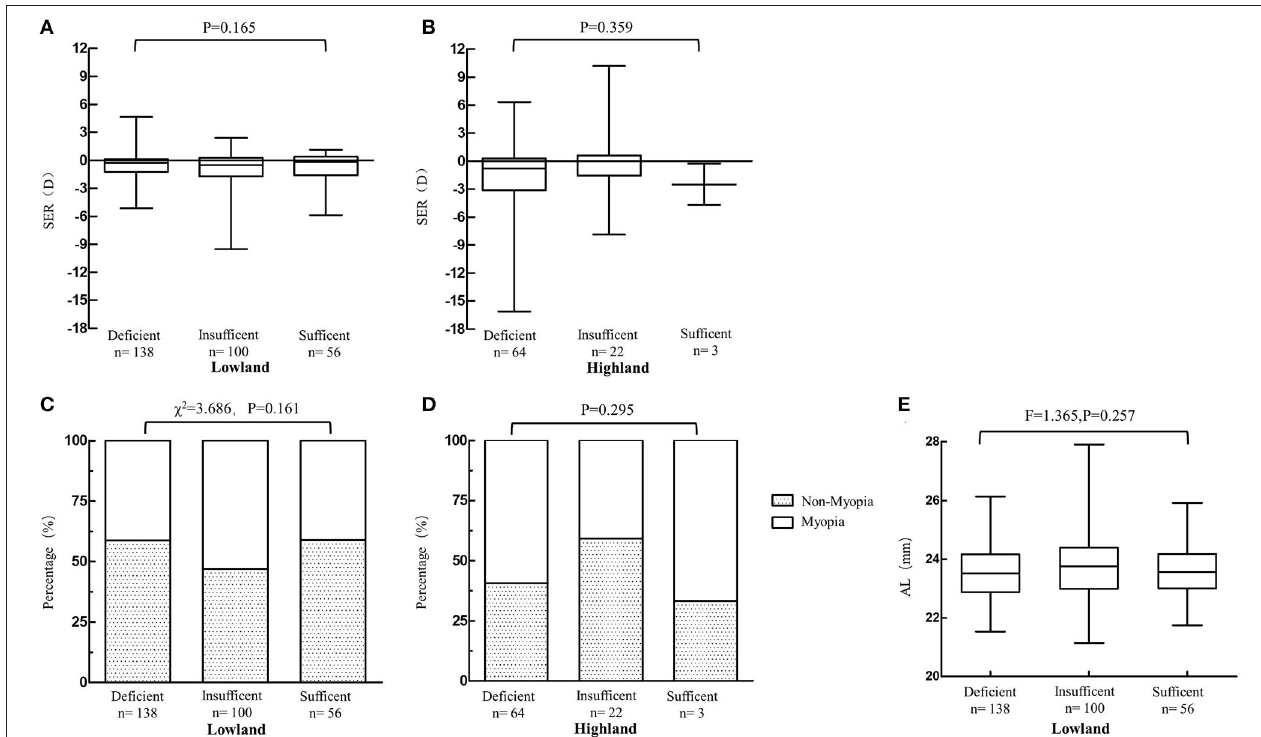
FIGURE 1 | Myopia related parameters among groups with different serum vitamin D [25(OH)D] concentration in both areas. (A,B) Average SER among groups with different serum vitamin D concentration in both areas (Wilcoxon rank sum test). (C,D) Percentage of myopia and non-myopia among groups with different serum vitamin D concentration in both areas (Lowland: Chi-square test; Highland: Fisher exact test). (E) Axial length among groups with different serum vitamin D concentration in lowland subjects (Wilcoxon rank sum test).